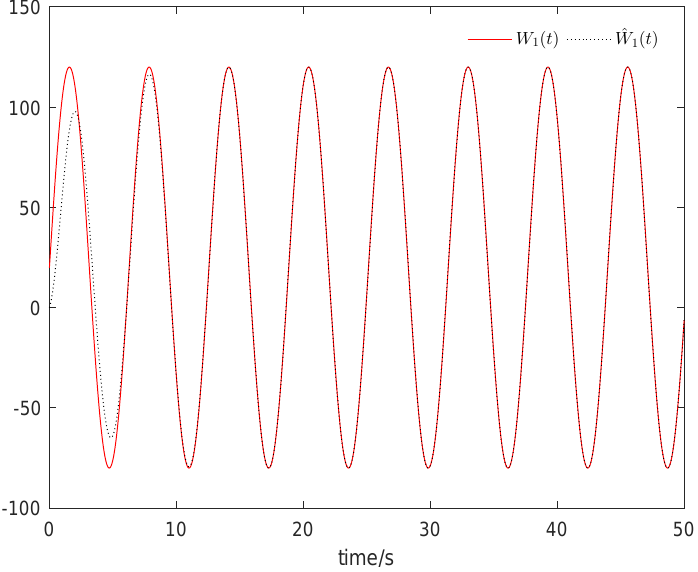
Figure 11. ˆ W 1 ( t ) tends to W 1 ( t ) .